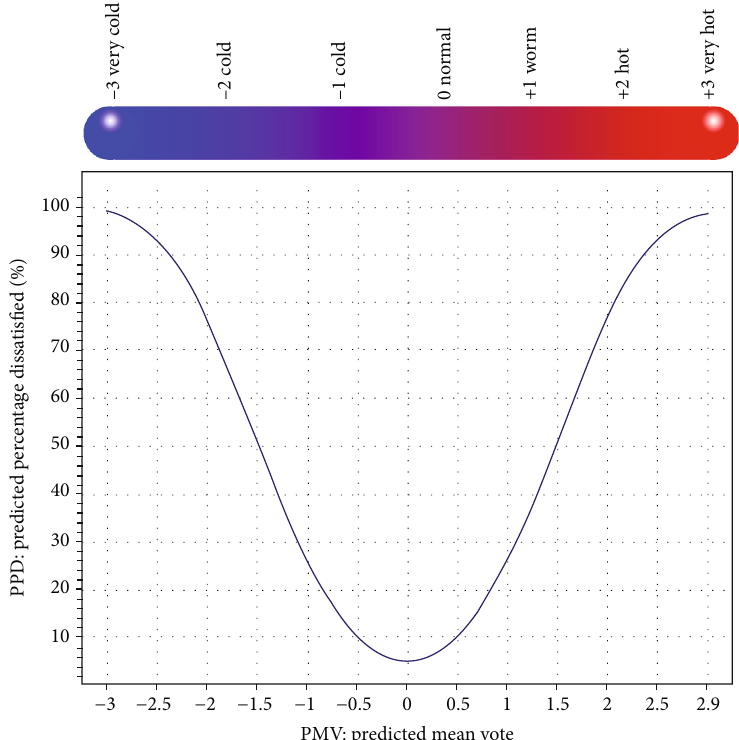
Figure 8: The relationship between PMV and PPD.